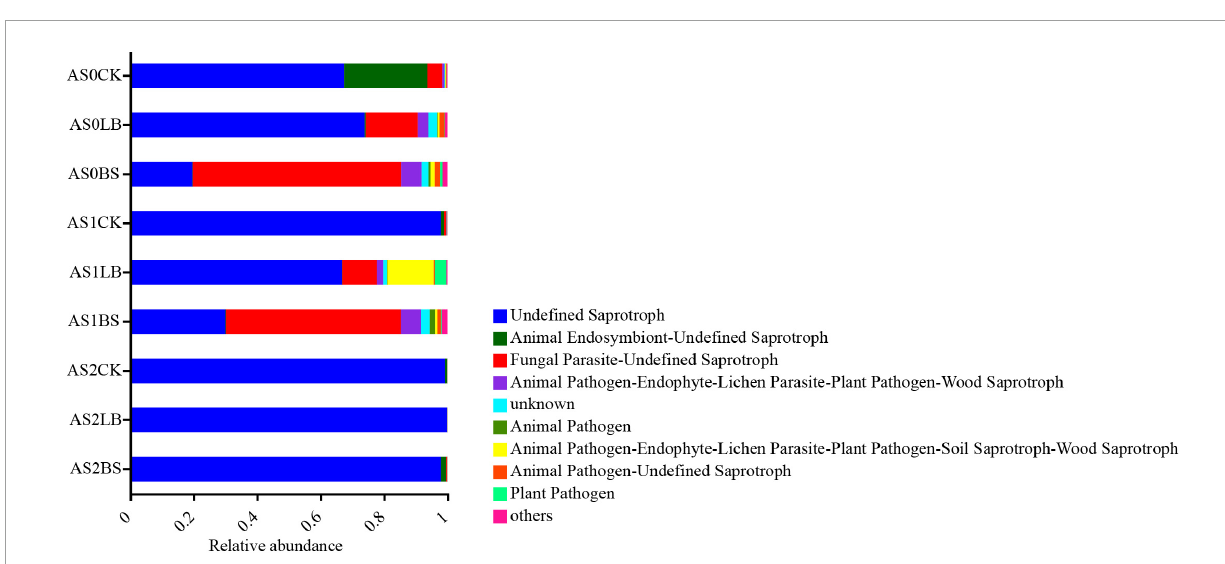
FIGURE9 Variations in composition of fungal functional groups inferred by FUNGuild during aerobic exposure. AS0CK, not inoculated silage at 0 h of aerobic exposure; AS0LB, Lentilactobacillus buchneri inoculated silage at 0 h of aerobic exposure; AS0BS, inoculated Bacillus subtilis silage at 0 h of aerobic exposure; AS1CK, not inoculated silage at 18 h of aerobic exposure; AS1LB, Lentilactobacillus buchneri inoculated silage at 18 h of aerobic exposure; AS1BS, inoculated Bacillus subtilis silage at 18 h of aerobic exposure; AS2CK, not inoculated silage at 60 h of aerobic exposure; AS2LB, Lentilactobacillus buchneri inoculated silage at 60 h of aerobic exposure; AS2BS, inoculated Bacillus subtilis silage at 60 h of aerobic